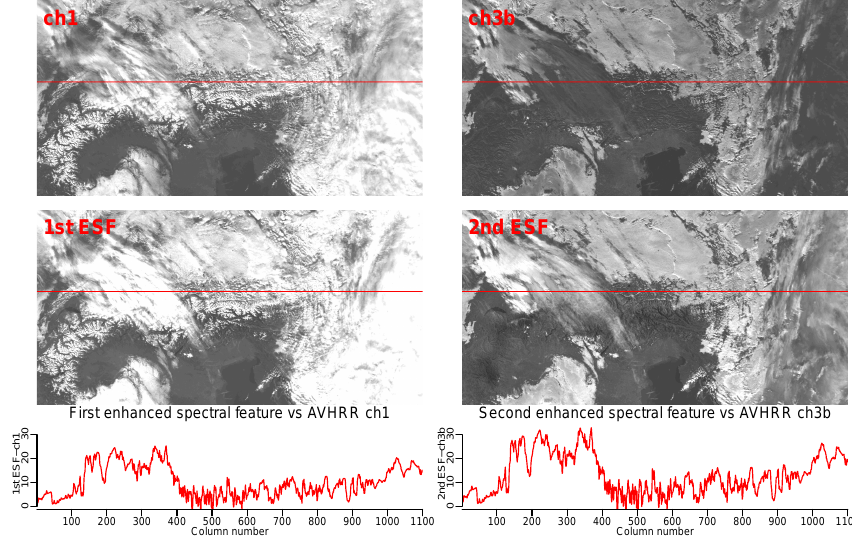
Fig. 1. Differences between enhanced spectral features (ESFs) generated by the invariant coordinate system (ICS) transformation and the AVHRR channel 1 (0.6µm) and channel 3b (3.7µm). Bottom panels depict the differences between the ESFs and the AVHRR reflectances retrieved from the spectral profiles marked as the red lines. For details see Sects. 3.2.2 and